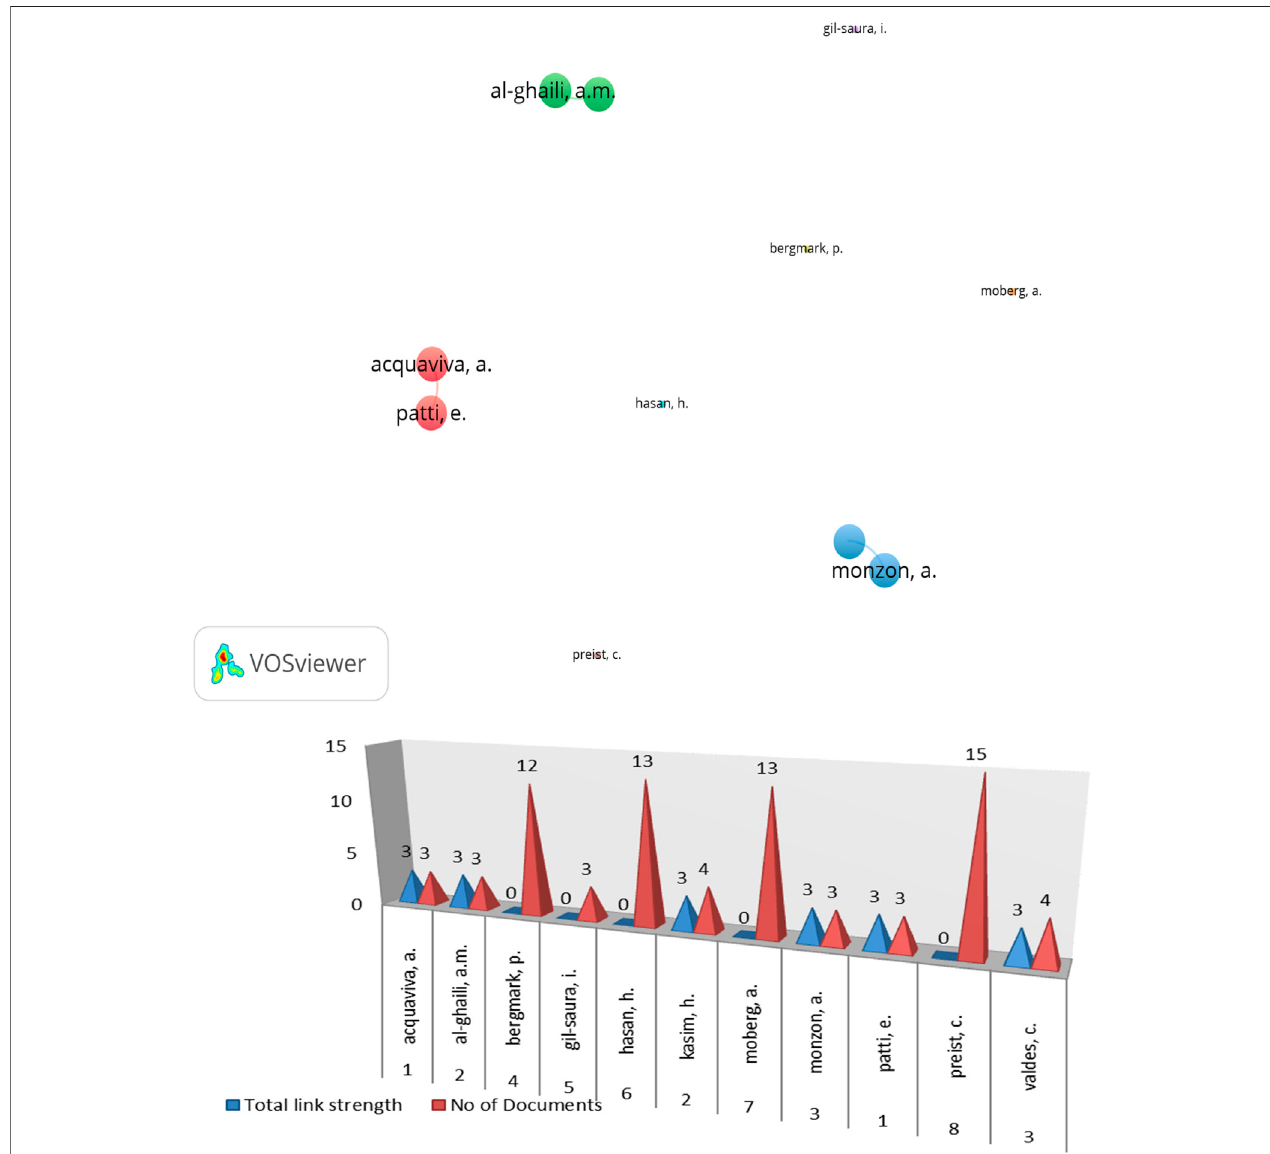
FIGURE 4 | Network of authors, number of documents and total link